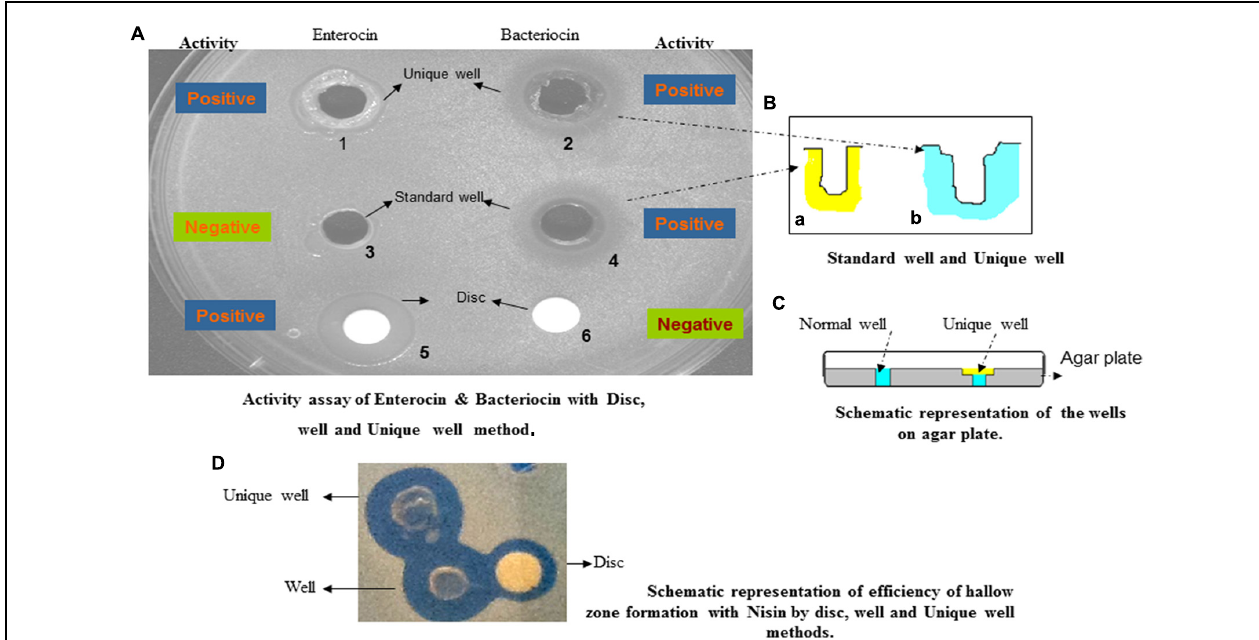
FIGURE 1 | (A–D) Bacteriocin and enterocin inhibition of a Micrococcus luteus indicator lawn on de Man, Rogosa, and Sharpe (MRS) agar medium. The producer strains are Bifiodobacterium catenulatum and Enteroccus gallinarum. (A) Wells 1 and 2 are unique wells, and they share the same structure as shown in (B) . Wells 3 and 4 are conventional wells made by a gel borer, and they share the same structure as shown in (B) . Numbers 5 and 6 are sterile disks placed on the lawn. Wells 1 and 3 and disk 5 correspond to enterocin, and wells 2 and 4, and disk 6 correspond to bacteriocin. (D) Nisin subjected to three different kinds of assays.